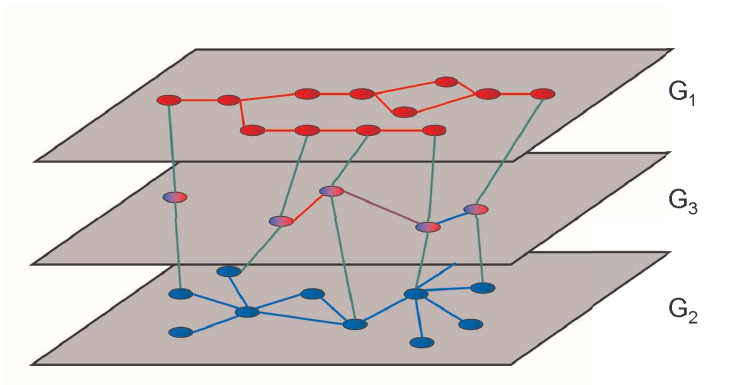
Figure 1: General layout approach. Two networks, G 1 shown in red on the top layer, G 2 shown in blue on the bottom layer and the overlapping nodes ( G 3 ) shown in red-blue on the middle layer. Edges connected to the overlapping nodes are shown in the middle layer. Edges existing only in G 1 are shown in red, edges existing only in G 2 are shown in blue, and those edges existing in both networks are shown in